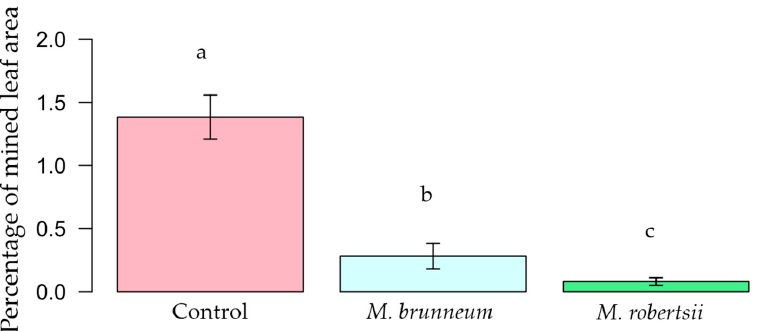
Figure 5. Percentage of leaf area mined by Leucoptera coffeella in coffee seedlings inoculated with Metarhizium robertsii and Metarhizium brunneum by soil drench. Inoculation of 30 mL of each isolate suspension was to the surface of the soil in each coffee seedling while the control received a sterile solution of Tween 0.05%. Bars with the same letters are not statistically different.